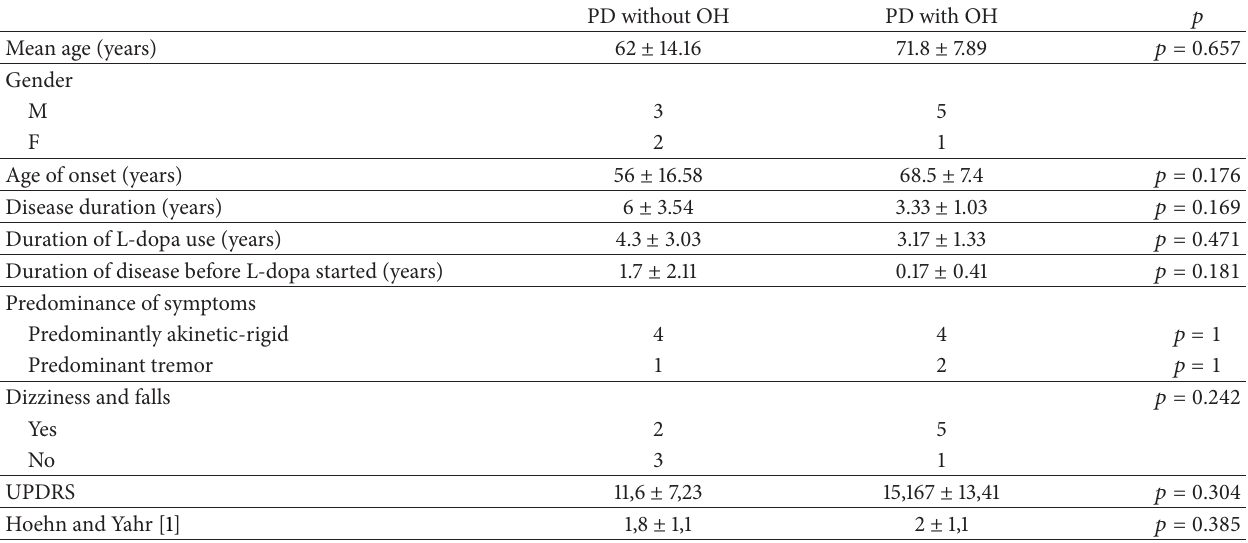
Table 2: Clinical and demographic data for the PD patients with and without orthostatic hypotension.